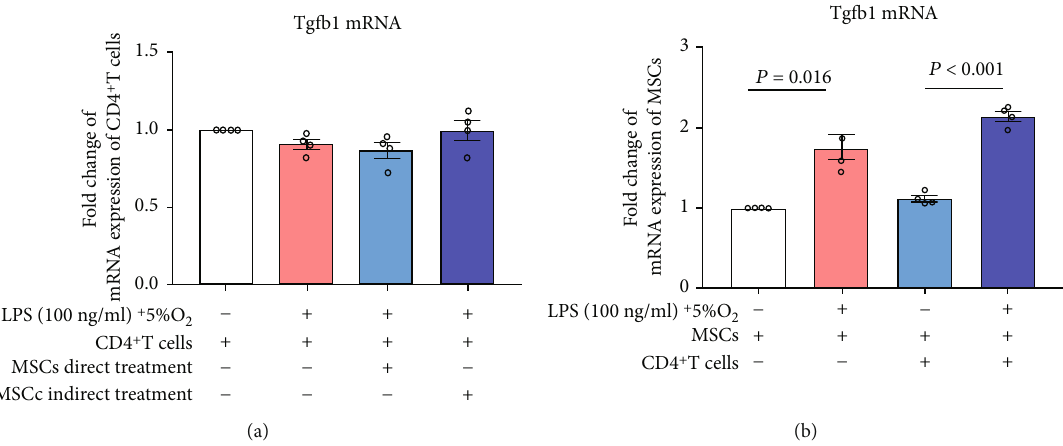
Figure 4: E ff ects of MSC-CD4 + T cell coculture and/or LPS-hypoxia stimulation on Tgfb1 mRNA expression of CD4 + T cells and MSCs. (a) Tgfb1 mRNA expression of CD4 + T cells receiving MSC treatments and/or LPS-hypoxia stimulation was detected by RT-PCR. (b) Tgfb1 mRNA expression of MSCs receiving indirect coculture with CD4 + T cells and/or LPS-hypoxia stimulation was detected by RT-PCR detection. LPS: lipopolysaccharide; MSC: mesenchymal stem cell; RT-RCR: real-time polymerase chain reaction; TGF: transforming growth